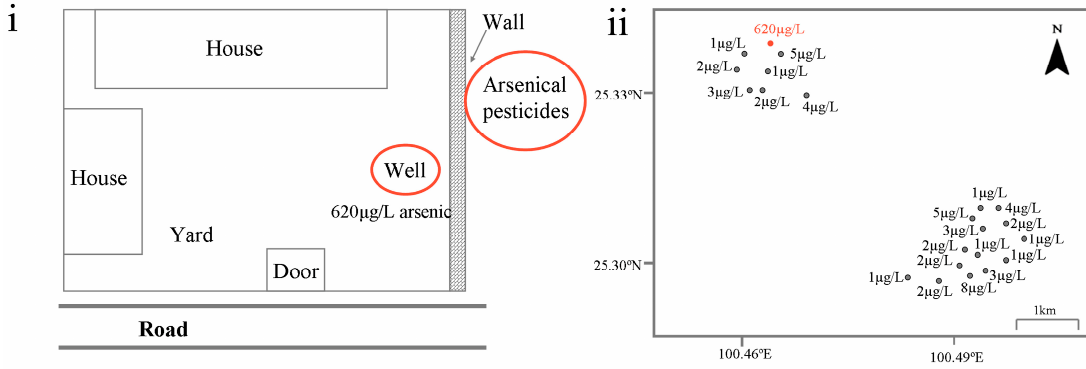
Figure 4. ( i ) The sketch of the family home (the red circles indicate the locations of arsenical pesticides and the well used to supply drinking water to the family from 1973 to 1989; the soil at the site where the arsenical pesticides were placed had been removed to pave the road in front of the door, which shown in bold); ( ii ) The geographical distribution and corresponding arsenic concentrations of the 21 groundwater samples collected near the family’s home (the red dot marked 620 µ g/L represents the geographical location of the home).